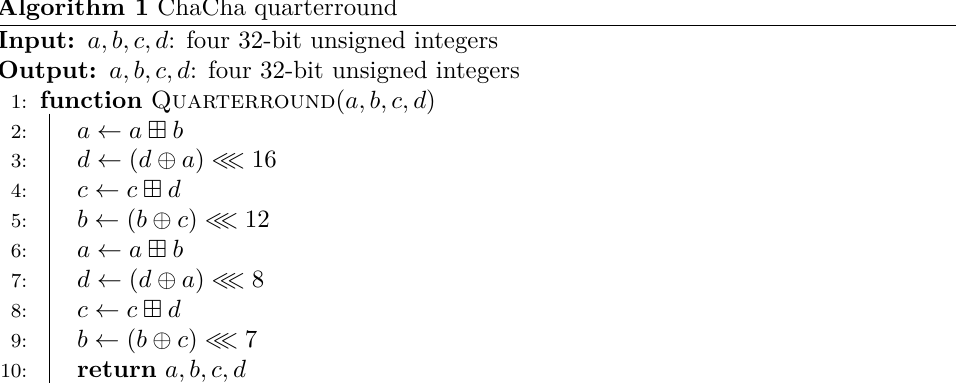
Algorithm 1 ChaCha quarterround